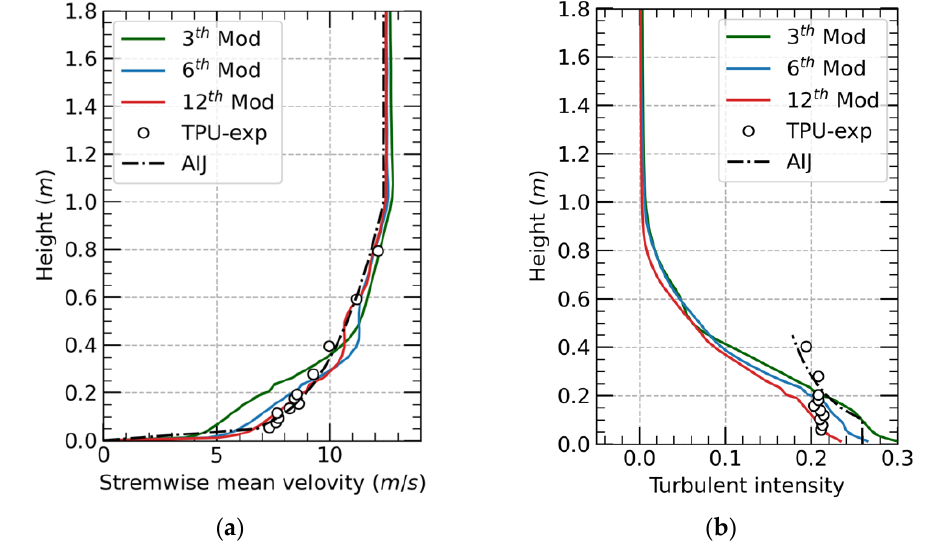
Figure 7. ( a ) The streamwise wind velocity profiles and ( b ) the turbulence intensity profiles of the simulated wind field during RRM process. The wind tunnel results and AIJ profiles are plotted for comparison.